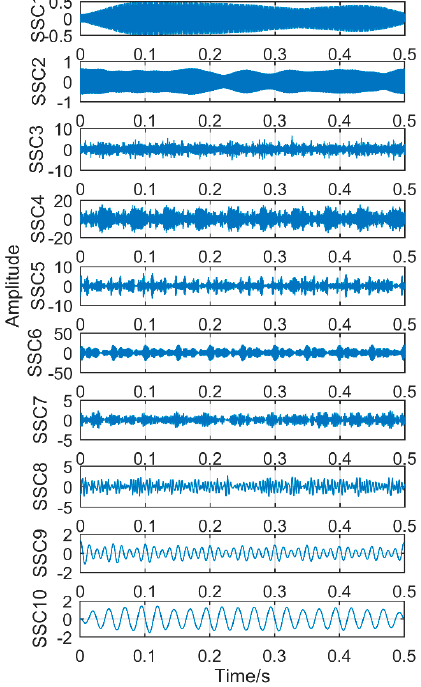
Figure 28. Time-domain diagram of decomposition results obtained by SSD.